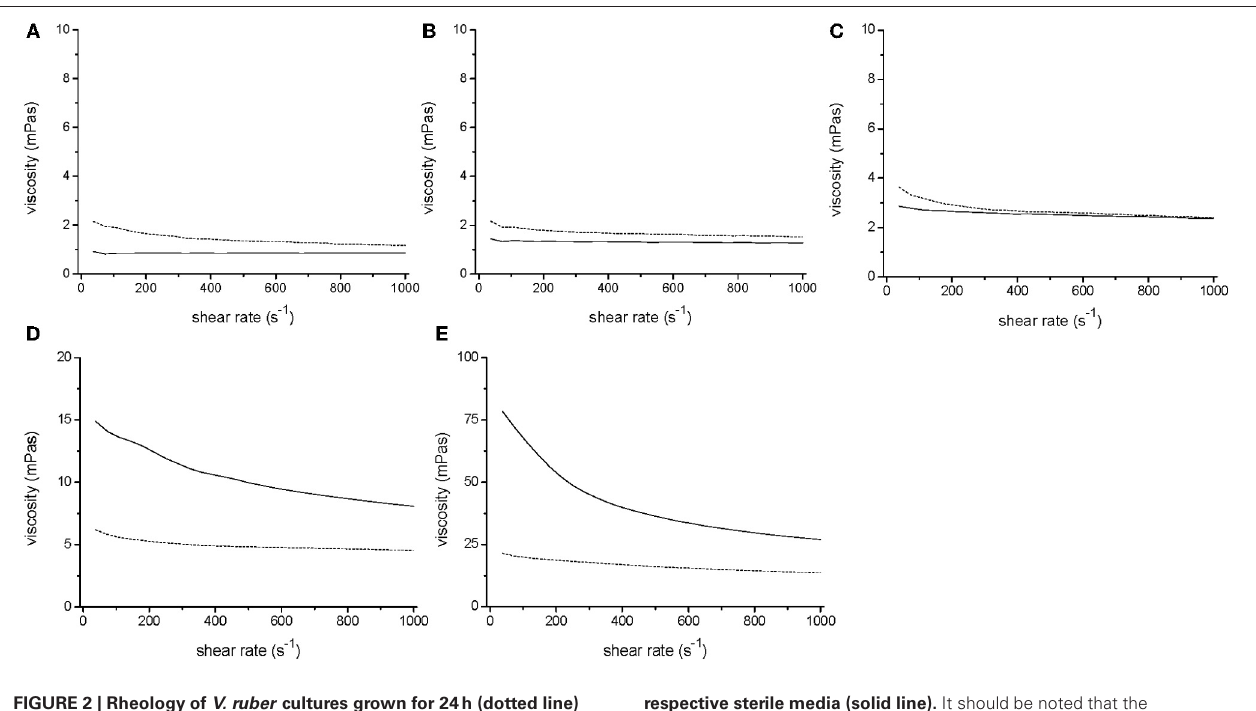
respective sterile media (solid line). It should be noted that the y-axis in panels D and E have different values, i.e., 0–20 and 0–100mPas, respectively.